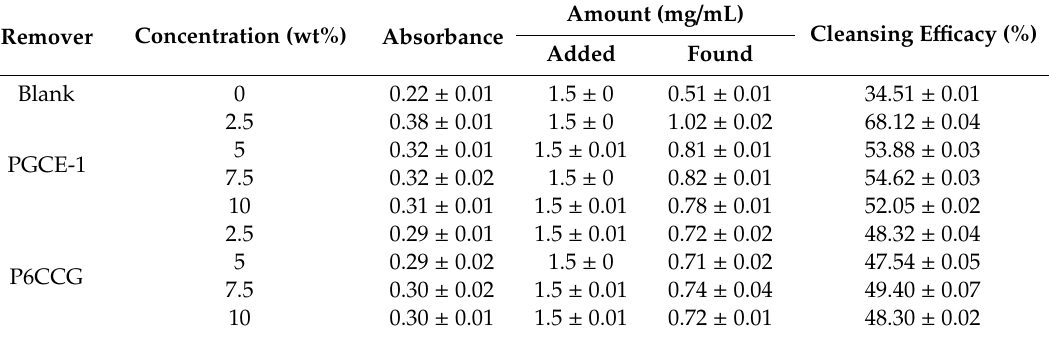
Table 4. In vitro cleansing e ffi cacy of PGCE-1 and polyethylene glycol (PEG)-6 caprylic / capric glycerides (P6CCG) against pen